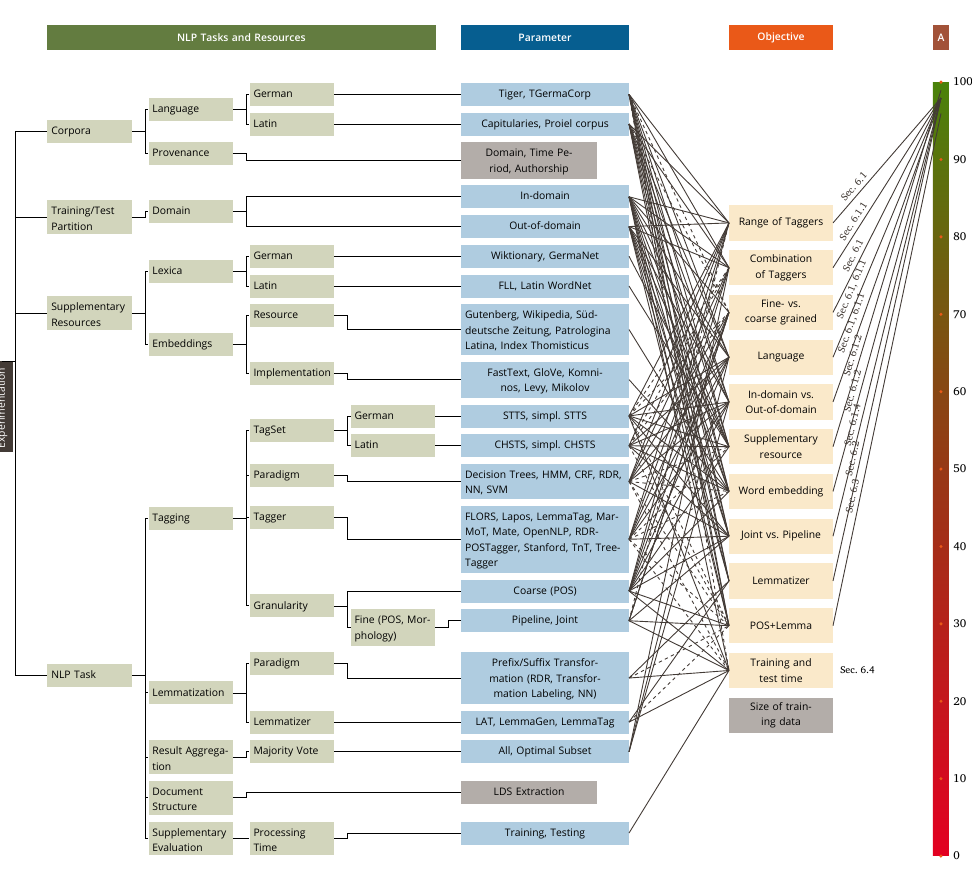
Figure 1: Roadmap for NLP evaluation. See main text for details. The tree on the left-hand side provides a systematization of tasks and resources for NLP. The leaf nodes (“Parameter” column) collect the parameter settings we employ to instantiate the relevant cells of the systematization grid. Parameters that are not part of the current paper are shaded in gray. The parameters are mapped in different ways on to the evaluation objectives, as indicated by connecting lines. Dashed lines indicate that the parameter instantiation in question is not fully exhausted by the target evaluation objective. The scale on the right-hand side depicts the maximum accuracy of the evaluation results for each objective, and indicates the section where the relevant evaluation study is described